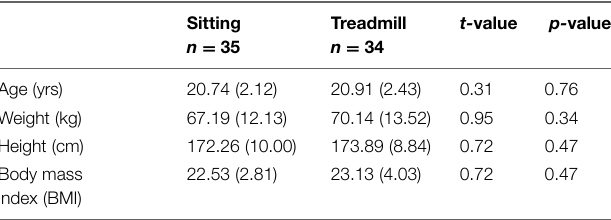
TABLE 1 | Demographic and fitness characteristics of sitting and treadmill walking